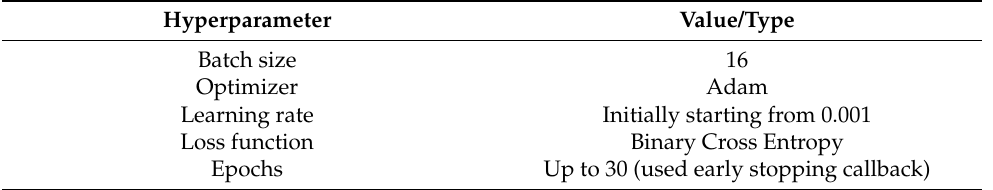
Table 3. Hyperparameters for model